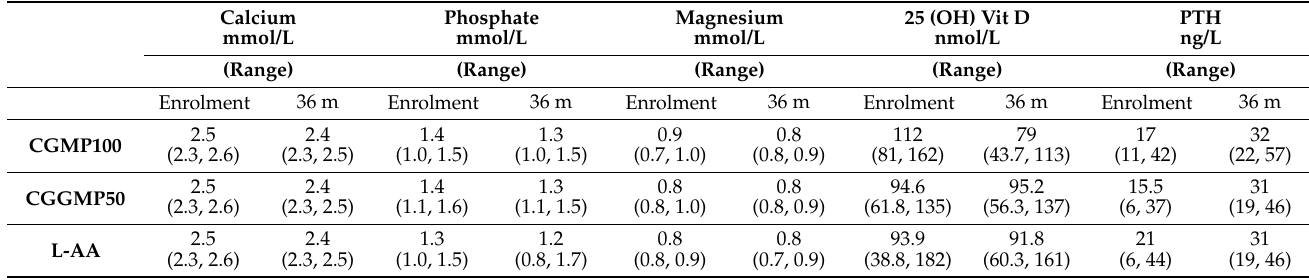
Table 4. Median (range) biochemical bone markers at enrolment and 36 months for CGMP100, CGMP50, and L-AA groups. Calcium